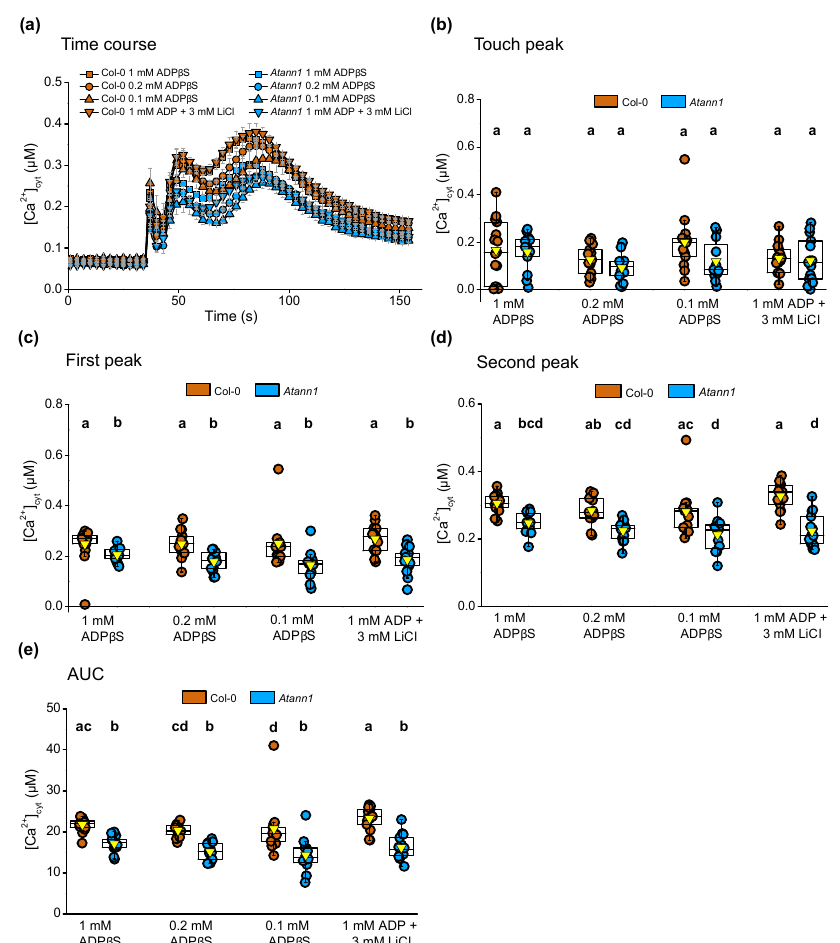
Figure 4. AtANN1 is involved in the eADP β S-induced [Ca 2+ ] cyt response at all concentrations tested. ( a ) Mean (± SEM) [Ca 2+ ] cyt time course in response to different concentrations of eADP β S or ADP with LiCl control from 3 experiments ( n = 13—15 per genotype and treatment). ( b ) The [Ca 2+ ] cyt touch peak values (± SEM), ( c ) first peak [Ca 2+ ] cyt values (± SEM), ( d ) second peak [Ca 2+ ] cyt values (± SEM) and ( e ) the total [Ca 2+ ] cyt accumulated obtained from AUC (± SEM) for each concentration tested in both Col-0 and Atann1 extracted from the time courses. p -values were obtained from ANOVA with Tukey’s post-hoc test or Kruskal-Wallis test for non-parametric approach. Different lower case letters indicate a significant difference between means ( p < 0.05).